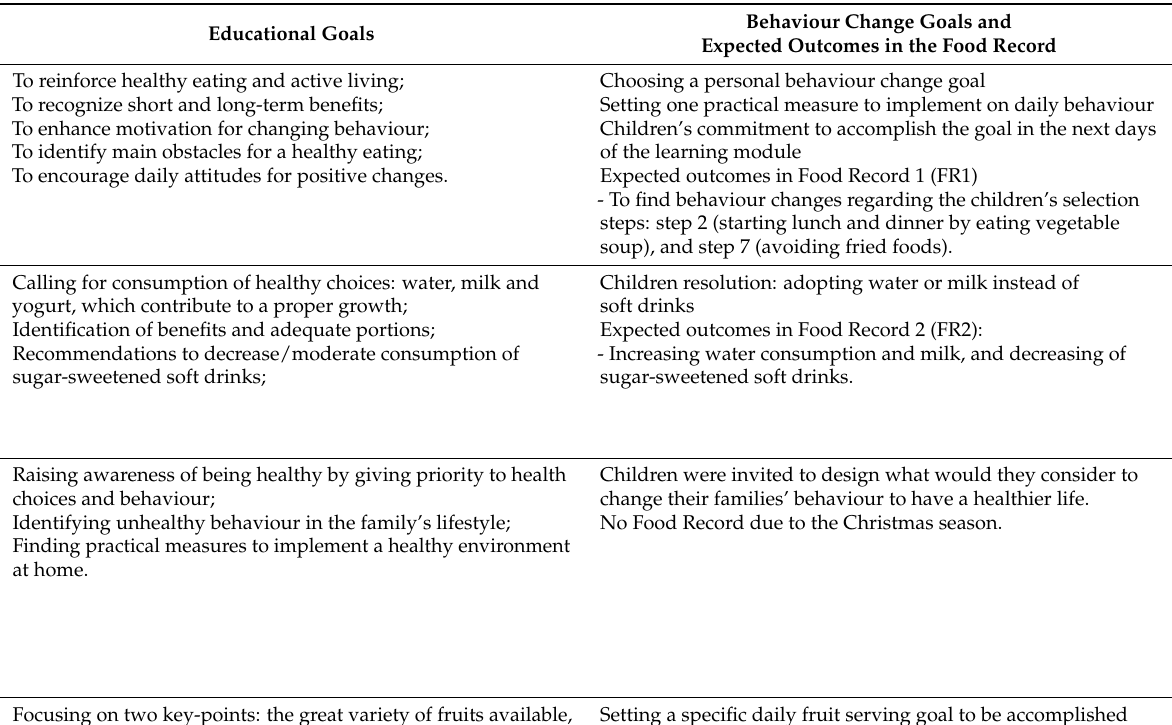
Table 1. Learning modules of the intervention and related educational and behaviour change